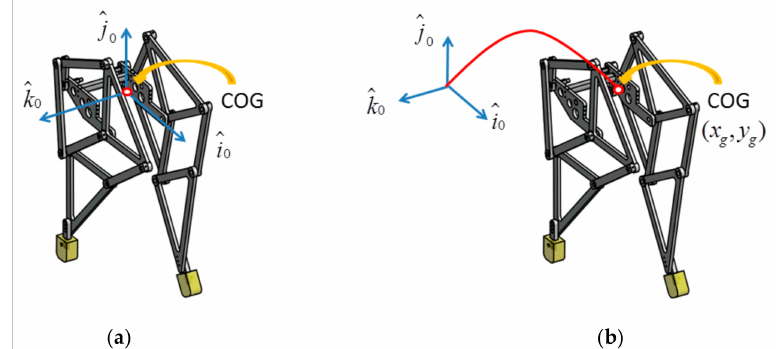
Figure 7. A simplified model of the robot: ( a ) Initial configuration and ( b ) motion of the center of gravity Projection (COG).